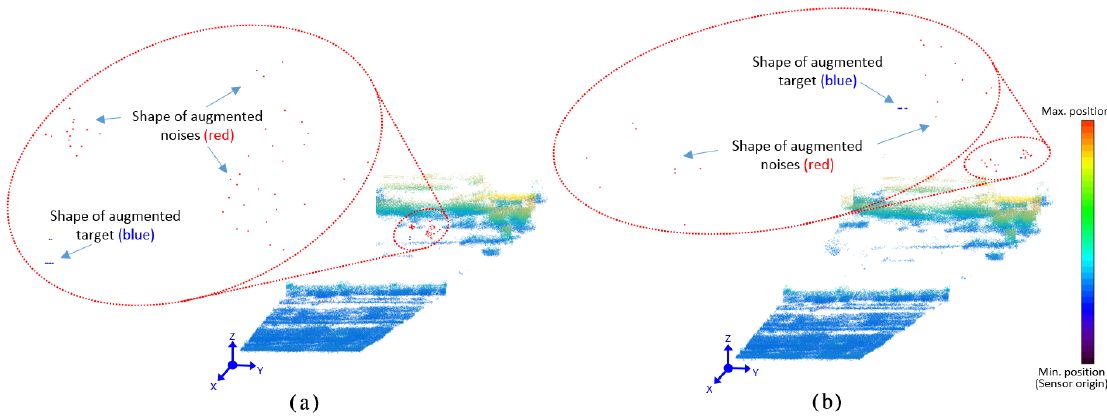
Figure 6. Shape of targets and noises at different ranges. ( a ) target shape at middle range, ( b ) target shape at far range.